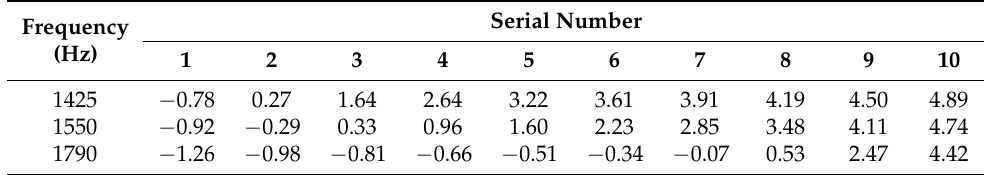
Table 1. The reflection phase of ten SHCs.